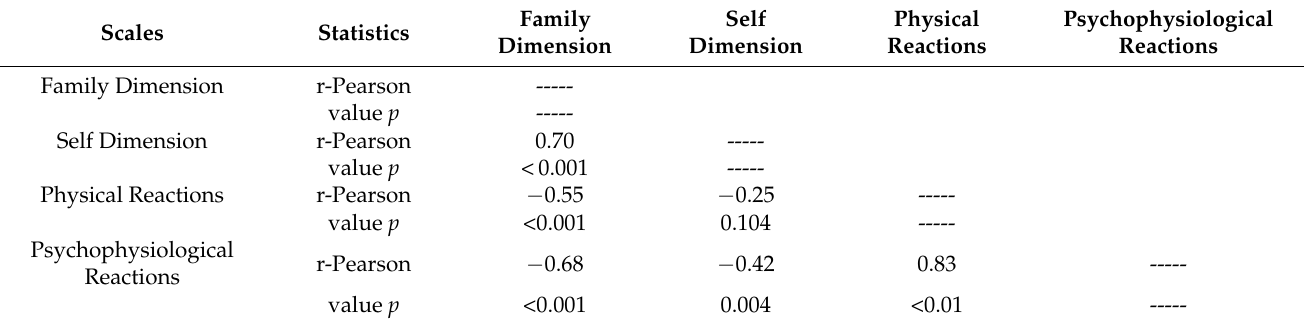
Table 6. Correlations between the Infantile Stress and Multidimensional Life Satisfaction